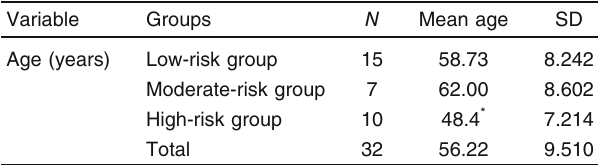
Table 3. There was a statistically association between the site of tumor ( P = 0.002) and postoperative aspiration. On the other hand, the severity of aspiration increased with rise of tumor stage (from MPAS 2 with T1 to 3 with T2 to 4 with T3), rise of nodal stage (from MPAS: 3 with N0 to 4 with N1) and presence of preoperative radiochemotherapy (from MPAS: 3 in absence to 4 with presence of preoperative radiochemotherapy). However, these relations did not achieve statistical significance (Table 3). Table 2 Correlation of age to the different aspiration risk groups Variable